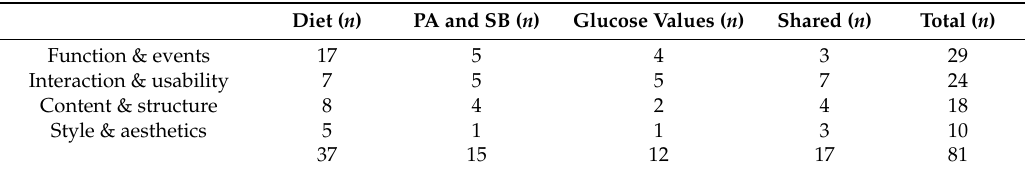
Table 1. The number of formulated requirements as a result of the cohort study, literature search, pilot study, and expert meetings per FICS category for diet, physical activity (PA), and sedentary behaviour (SB), glucose values and